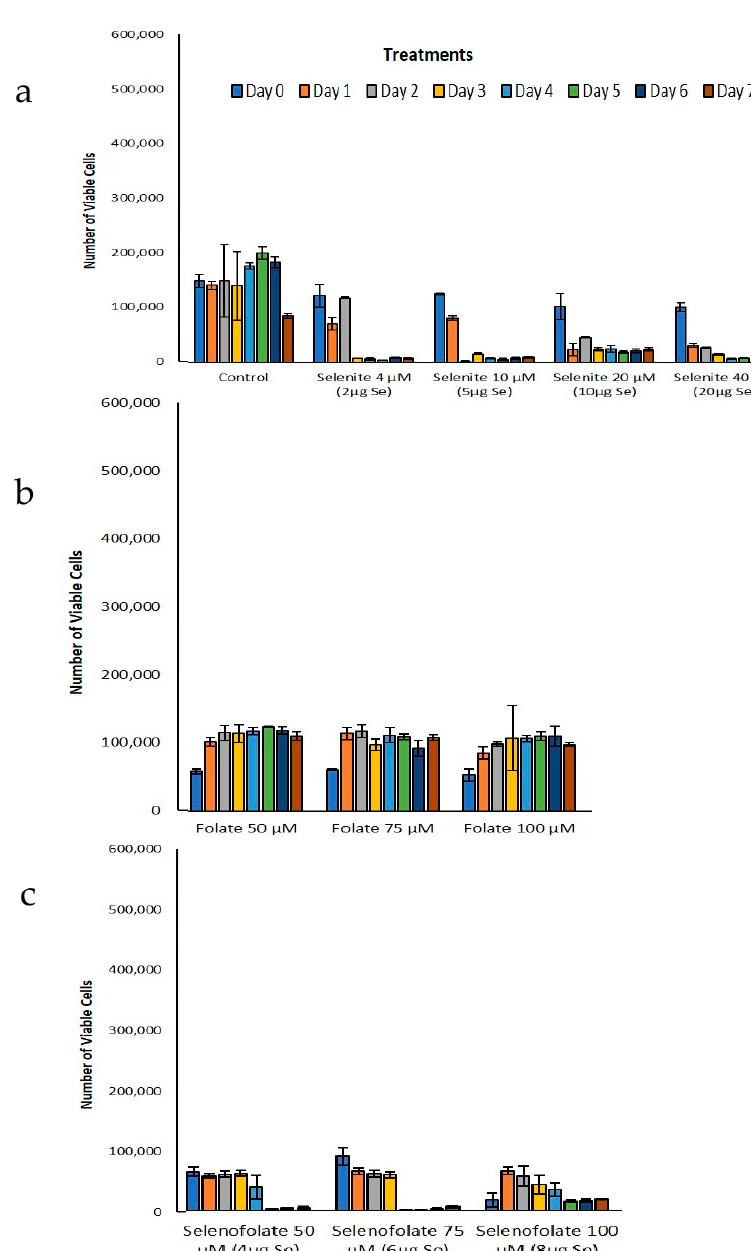
Figure 6. Analysis of treatment cytotoxicity in HME50-5E cells. Cytotoxic e ff ects of ( a ) control and selenite, ( b ) Folic Acid, ( c ) Selenofolate treatments against HME50-5E cells was determined as a function of percent cell viability. Forty-thousand cells were seeded and treated as shown (Day 0 = start of treatment) with 5 µ M, 25 µ M, 50 µ M, 75 µ M and 100 µ M Folic acid and Selenofolate with Se equivalents of 0.4 µ g, 2 µ g, 4 µ g, 6 µ g, and 8 µ g respectively. Viable cells were counted and analyzed by Trypan Blue exclusion every 24 h for 7 days. The data are expressed as mean ± SE ( n = 3). Statistical treatments were compared using two sample t-tests. Treatments that were statistically significant, p ≤ 0.05